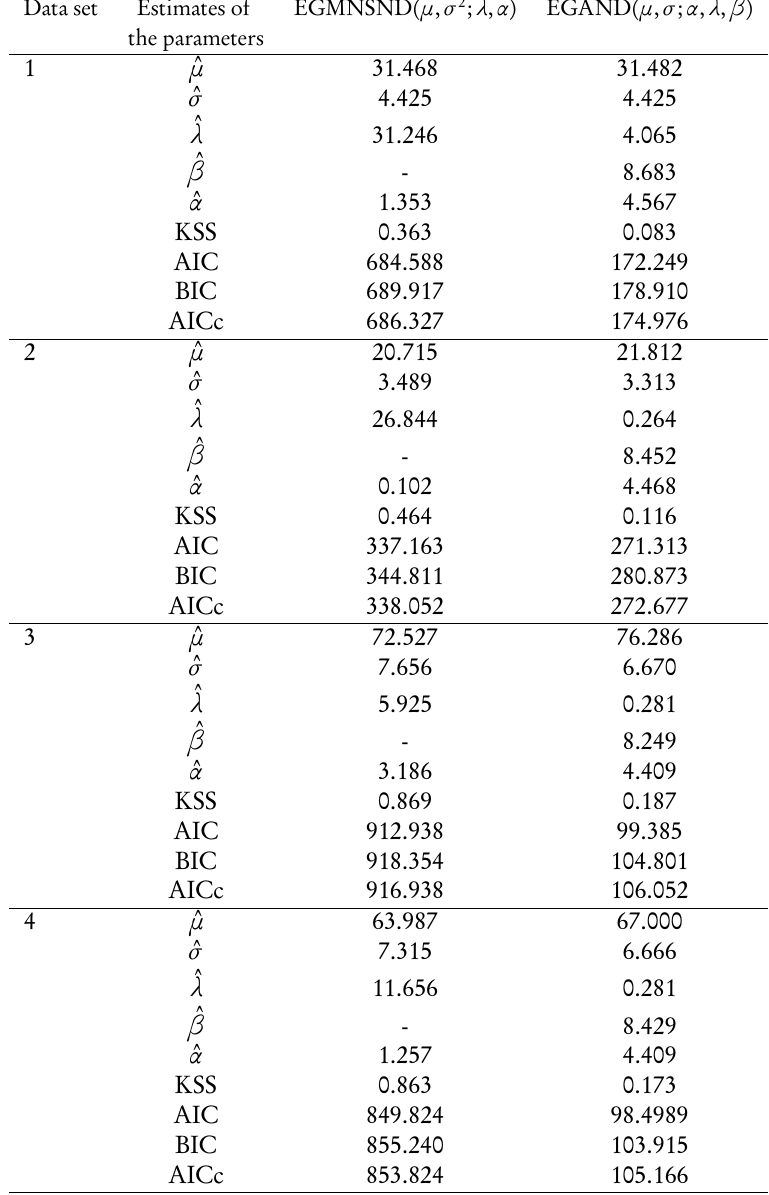
Estimated values of the parameters for the model: EGMNSND( µ , σ 2 ; λ , α ) and EGAND( µ , σ ; α , λ , β ) with respective values of KSS, AIC, BIC and AICc in case of data sets 1, 2, 3 and